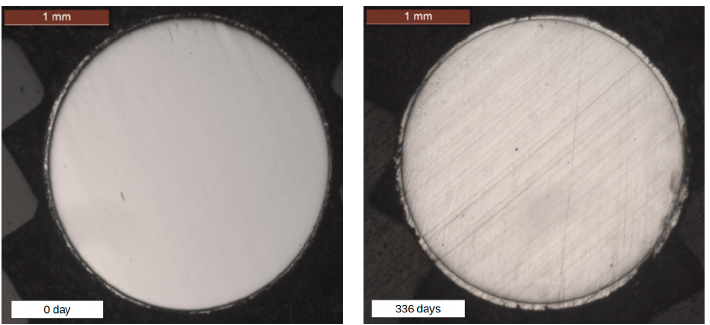
Figure 7. Transverse cross section of a corroded steel wire in an ungreased cable.